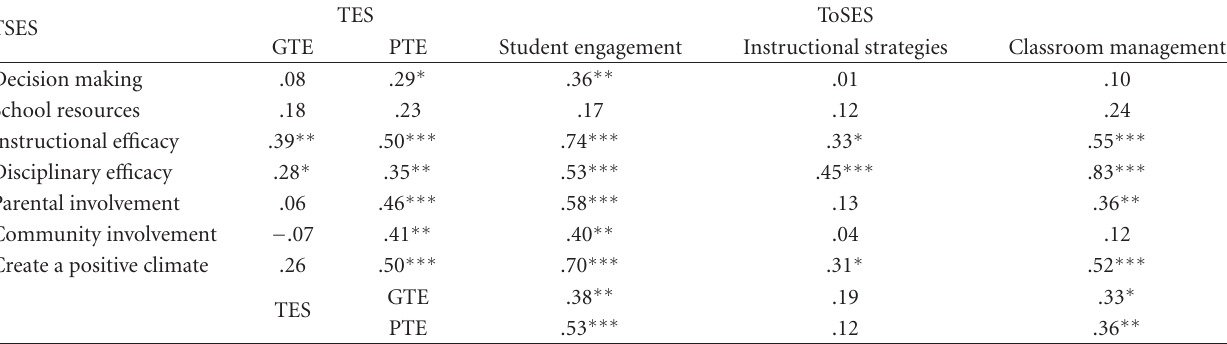
Table 1: Correlation between teacher e ffi cacy scales.